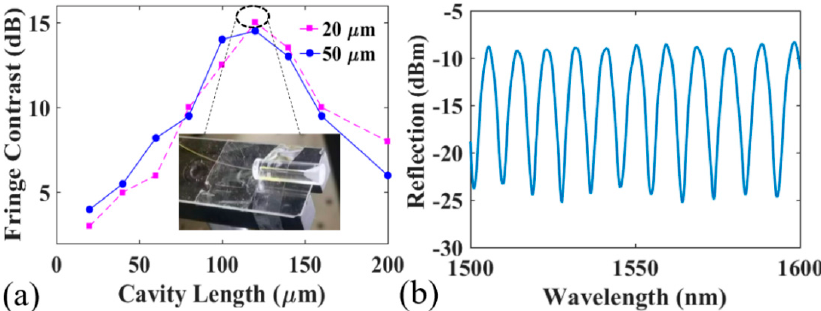
Figure 5. ( a ) The measured fringe contrast versus FP cavity with the composite diaphragm with different thicknesses and ( b ) measured reflection spectrum of the device of the inset showed in ( a ).